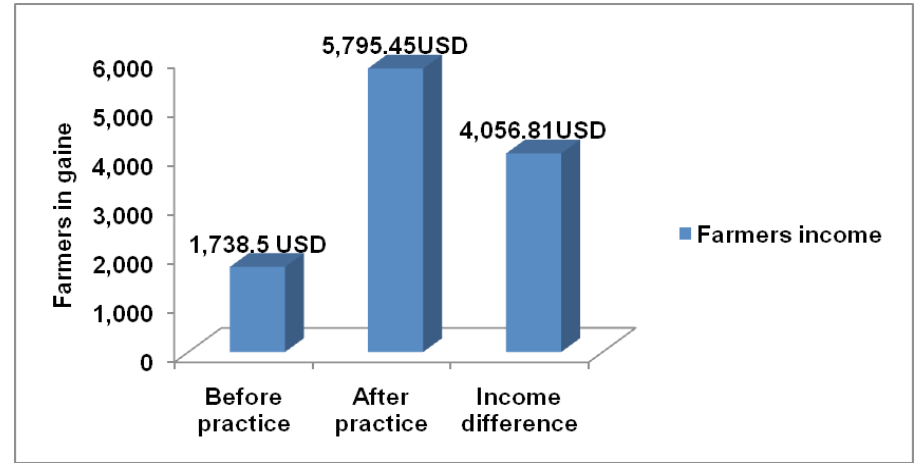
Figure 1: Average income gain of farmers’ before and after the